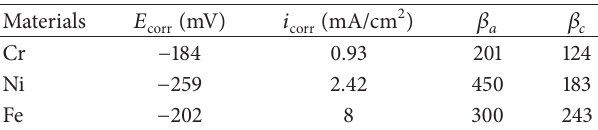
Table 1: Electrochemical parameters from potentiodynamic polar- ization curves for Cr, Ni, and